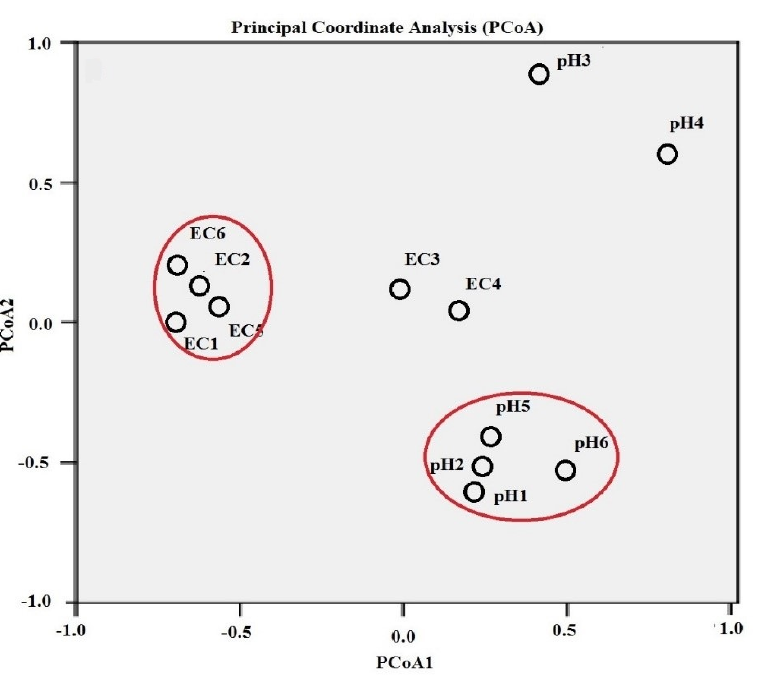
Figure 3. Principal coordinate analysis (PCoA) plot of the EC and pH value of the soil corre- sponding to the plant host. Both letters of EC1, EC2, EC3, EC4, EC5, EC6 and pH1, pH2, pH3, pH4, pH5, pH6 refer to electrical conductivities (ECs) and pHs of plant hosts as ordered in Table 1. PCoA was done based on a distance-dissimilarity matrix using Euclidean distance to have a plot in the common two-dimensional space showing the ordination of ECs and pH data sets. Red circles show the coordinated soils of Amaranthaceae close to one another in both EC and pH.